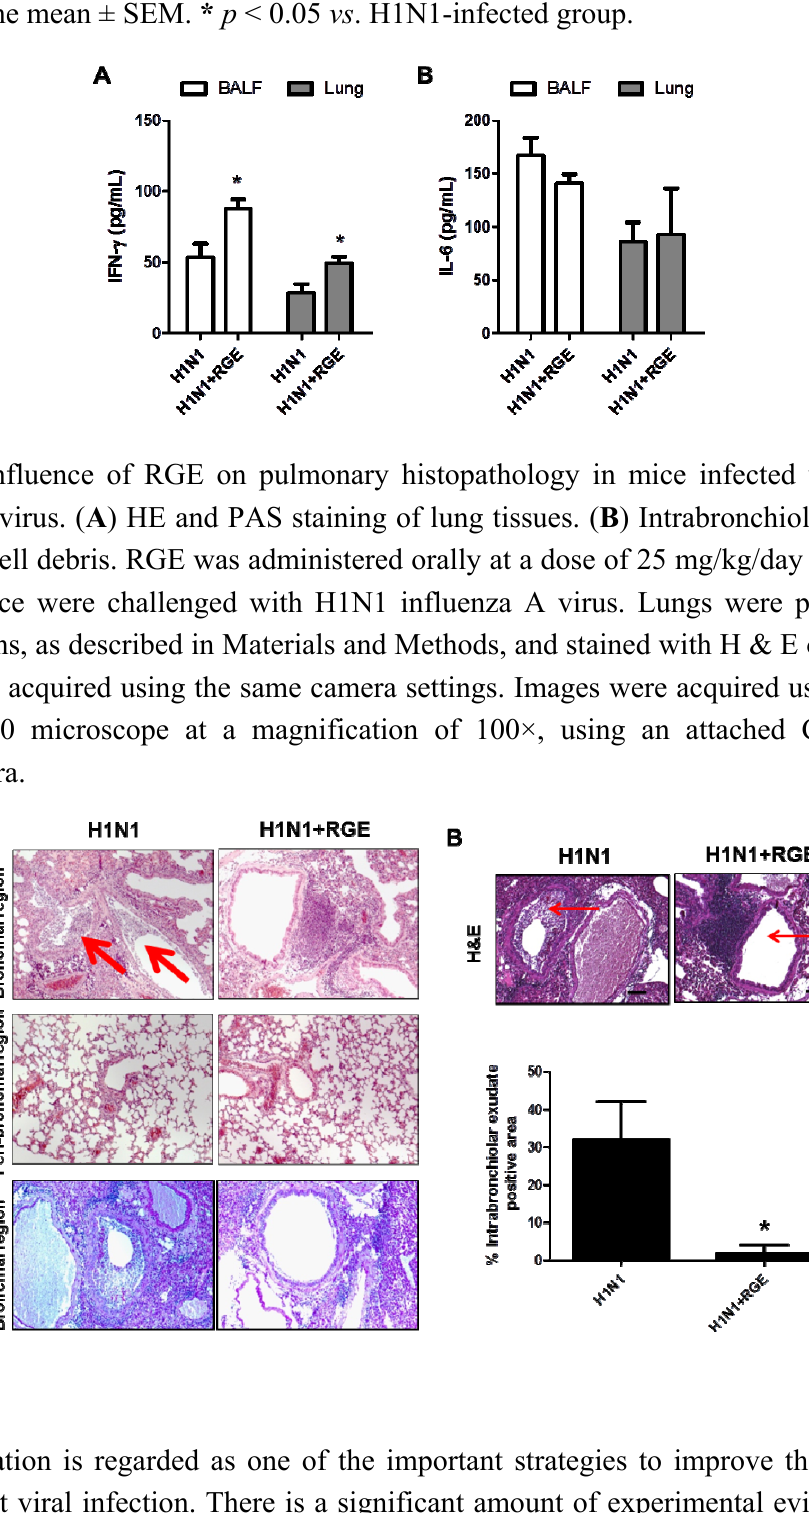
Figure 5. Influence of RGE on cytokines in mice infected with H1N1 influenza A virus. Cytokine IFN- γ ( A ) and IL-6 ( B ) levels of lung extract and bronchoalveolar lavage fluids (BALF) were determined at day 5 post infection ( n = 5). H1N1: naïve mice challenged with H1N1 influenza virus, H1N1 + RGE: RGE was administered orally at a dose of 25 mg/kg/day for 30 days and then mice were challenged with H1N1 influenza A virus. Values are the mean ± SEM. * p < 0.05 vs . H1N1-infected group.